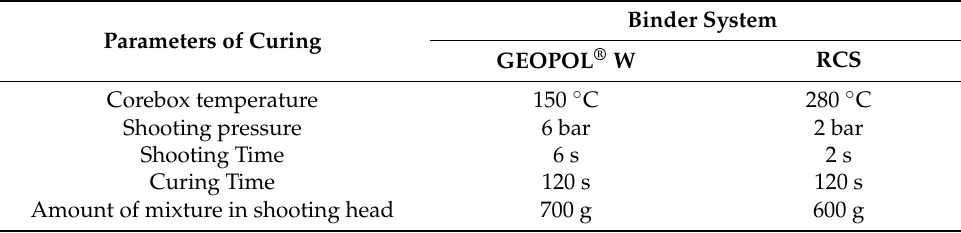
Table 1. Parameters for the production of test specimens for the evaluation of mechanical properties of mixtures and test cores. Binder System Parameters of Curing GEOPOL ® W RCS Corebox temperature 150 ◦ C 280 ◦ C Shooting pressure 6 bar 2 bar Shooting Time 6 s 2 s Curing Time 120 s 120 s Amount of mixture in shooting head 700 g 600